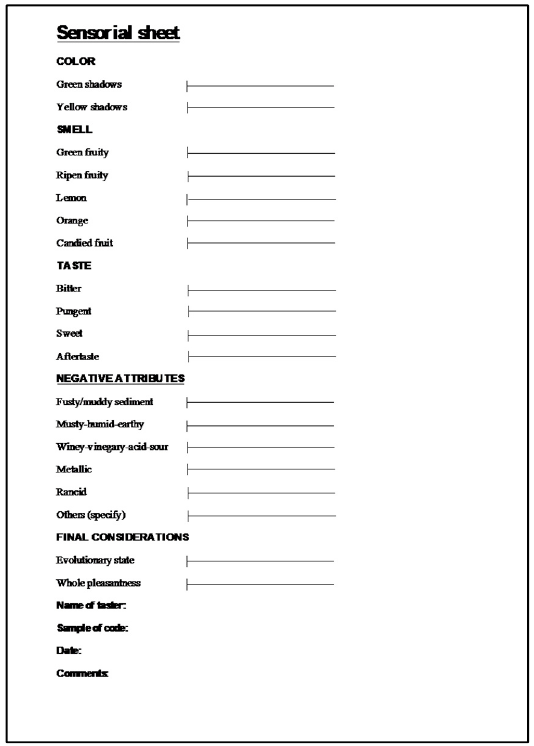
Figure 2. Technical evaluation sheet used for the sensory analysis.